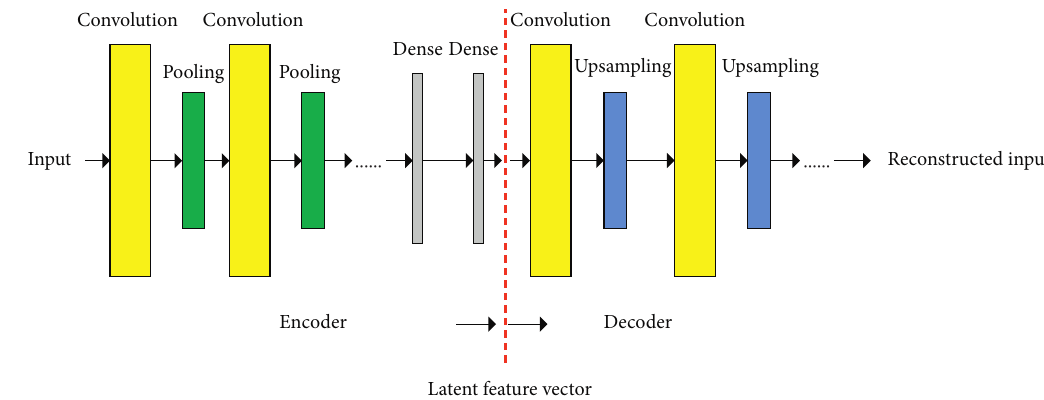
Figure 4: Illustrative architecture of the stacked convolutional